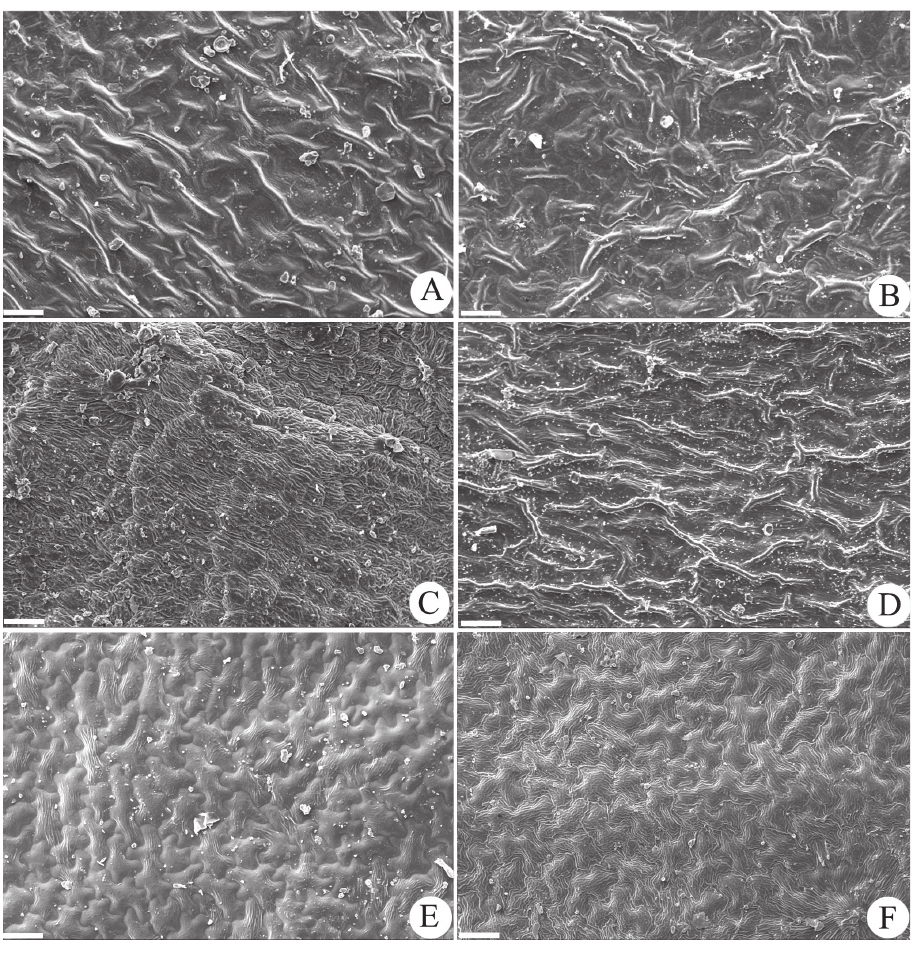
Figure 2. Adaxial leaf epidermal surface morphology of Asian Gerbera and Uechtritzia . A G. maxima B G. delavayi C G. gossypina D G. nivea E U. kokanica F U. lacei. Bar=50 μm